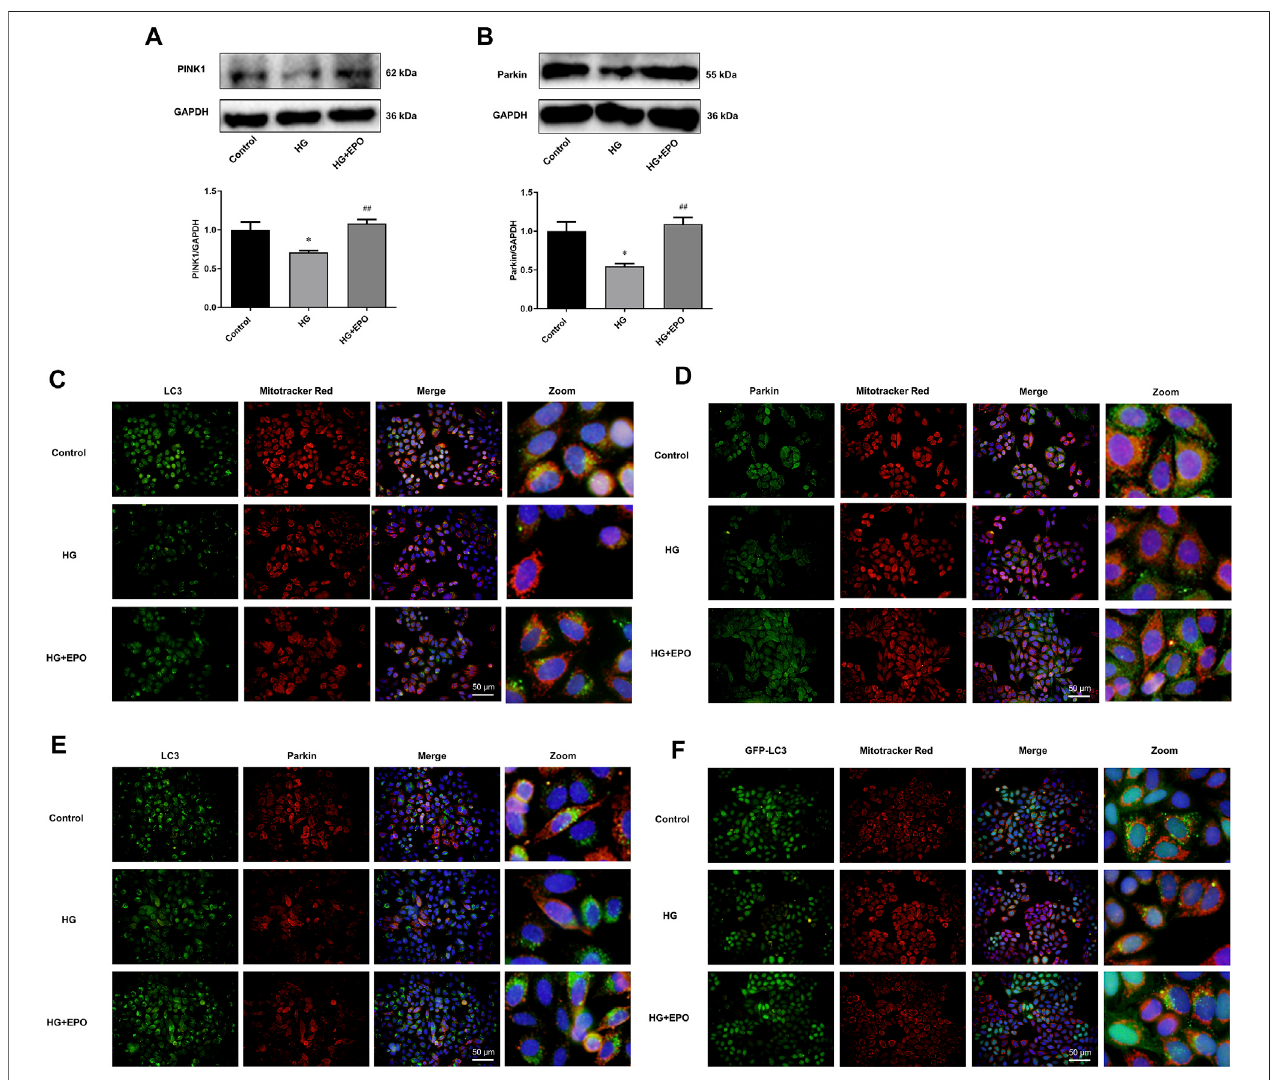
FIGURE3 | PINK1/Parkin-mediated mitophagy wasinvolved in the protective effectsofEPO on mesangial cells exposed to HG. Representative immunoblotsand quanti fi cation of (A) PINK1 and (B) Parkin. Immuno fl uorescence images of colocalization of (C) LC3 with mitochondria, (D) Parkin with mitochondria and (E) LC3 with Parkin aswellasthe (F) colocalization ofGFP-LC3 withmitochondria.Values arepresented asmean±SEM, n =3.* p < 0.05vs. Control group; # p < 0.05vs. HGgroup.